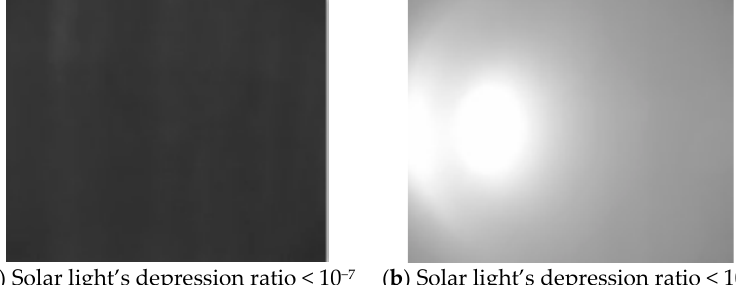
Figure 2. Typical images of stray light influences, using a collimated solar simulator and an imaging system with sensitivity of 10 − 7 solar flux.